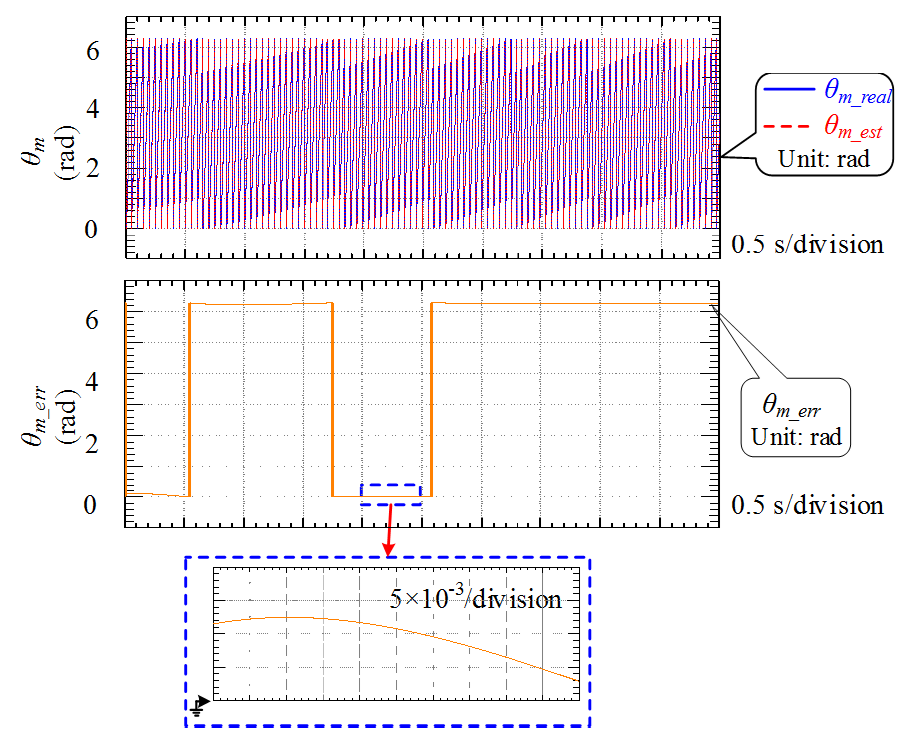
algorithm when wind speed = 15 m/s. when wind speed = 15 m/s.